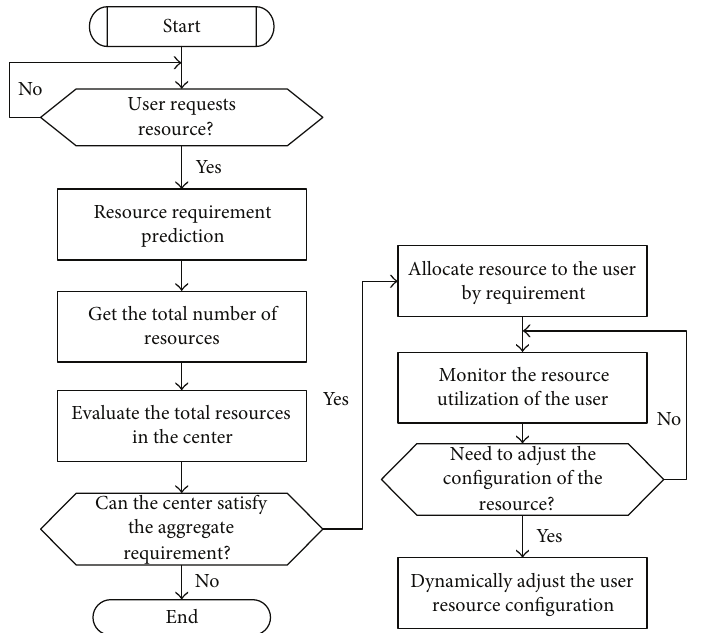
Figure 2: Dynamic resources supply of the cloud computing data